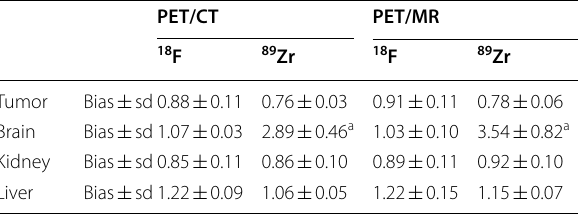
Table 1 Bland–Altman results for the comparison of tracer uptake quantification (%IA/g) assessed by PET imaging and by ex vivo biodistribution for [ 18 F]FDG and [ 89 Zr]Zr-DFO-NCS-